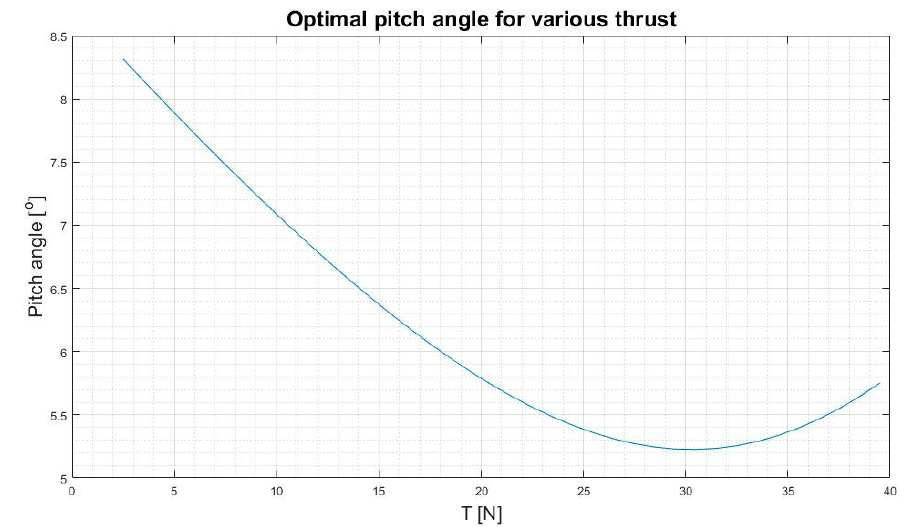
Figure 11. Optimal pitch for various thrusts.